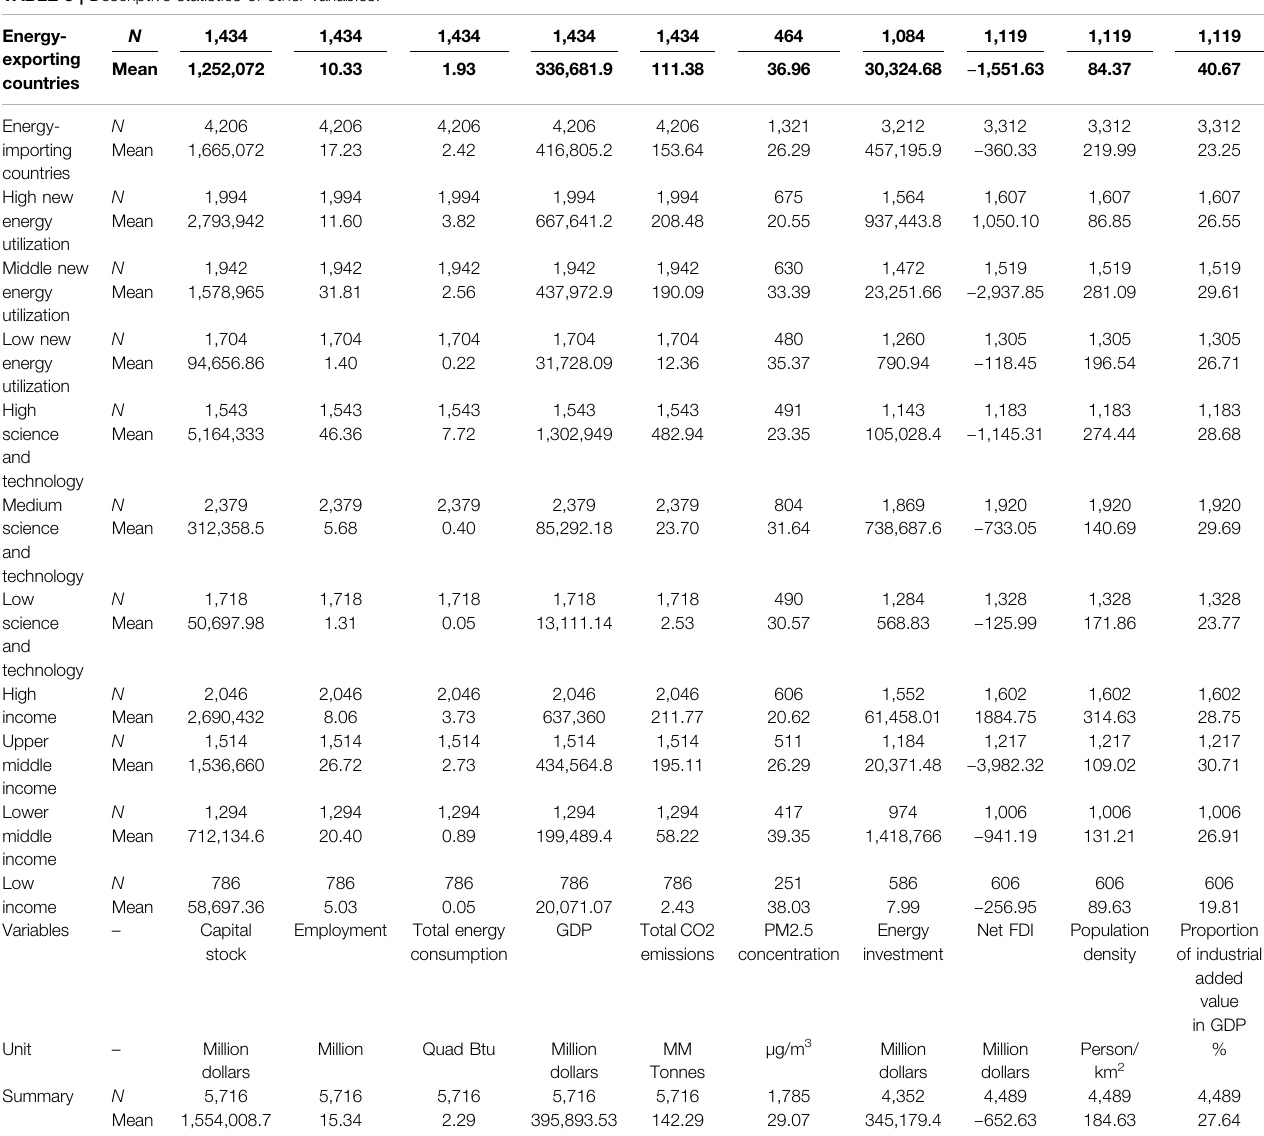
TABLE 3 | Descriptive statistics of other